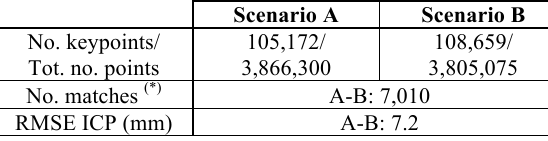
Table 3. Results of automatic point clouds pairwise registration. (*) after